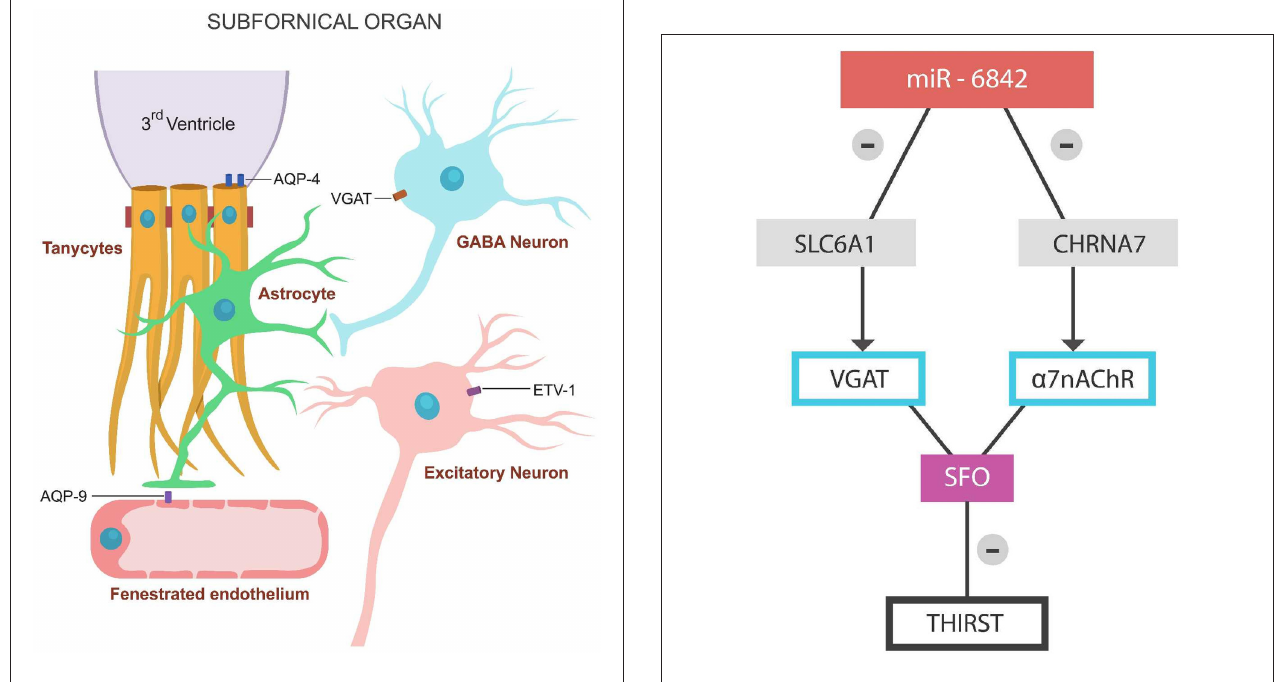
FIGURE 3 | Physiologically, microRNA-6842 silences SLC6A1 and CHRNA7 genes, activating the sensation of